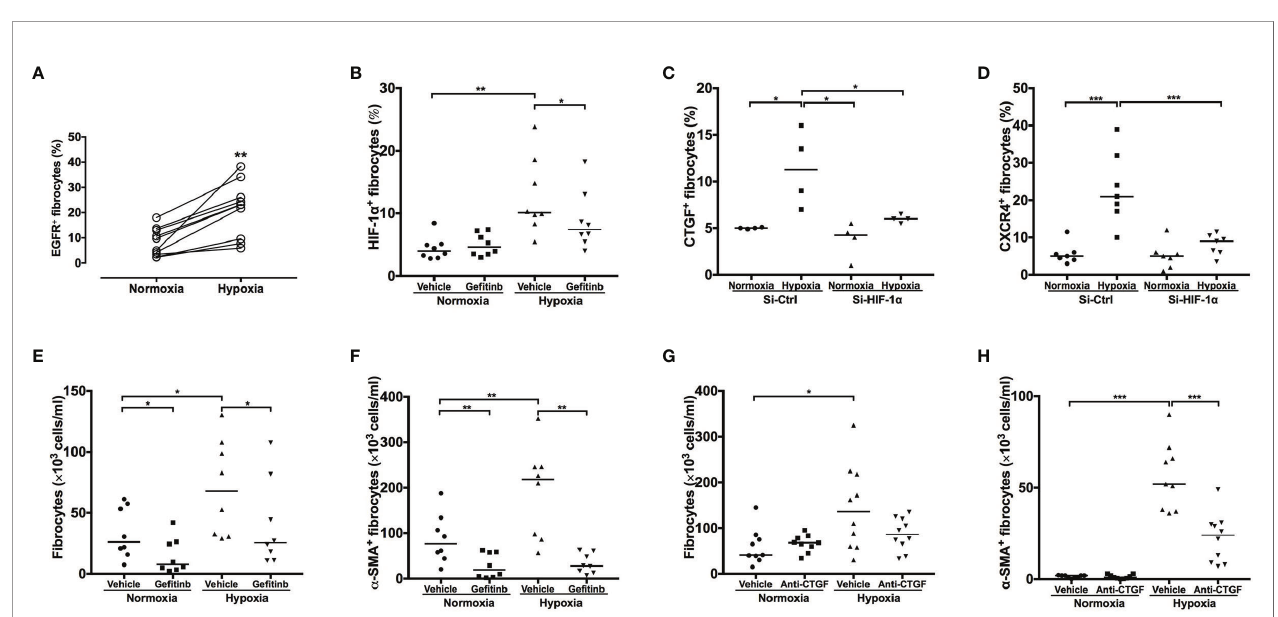
FIGURE 6 | EGFR and HIF-1 a inhibition and anti-CTGF antibodies blocked hypoxia-induced fi brocyte activation. NANT cells from COPD non-desaturators were exposed to normoxic (O 2 20%) or hypoxic (O 2 5%) condition for 24h and incubated in the presence of ge fi tinib (1 mm ) and anti-CTGF antibodies (1 m g/ml). The expression of EGFR at 24h (A) , HIF-1 a (B) , CXCR4 (C) and CTGF (D) at 2h and the number of fi brocytes (E, G) and a -SMA + differentiating myo fi broblasts (F, H) at 14 days were determined by fl ow cytometry. Horizontal lines represent the median values for each group * P < 0.05, ** P < 0.01, *** P < 0.001. EGFR, epidermal growth factor receptor; HIF-1 a , hypoxia-inducible factor-1 a ; CTGF, connective tissue growth factor; NANT cells, non-adherent non-T fraction of peripheral blood mononuclear cells; COPD, chronic obstructive pulmonary disease; CXCR4, CXC chemokine receptor 4; si-Ctl, siRNA control; a -SMA, a -smooth muscle